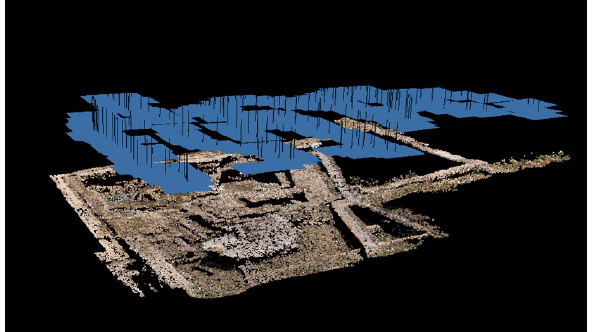
Figure 11. Camera position of the area of “San Giovanni” flight.